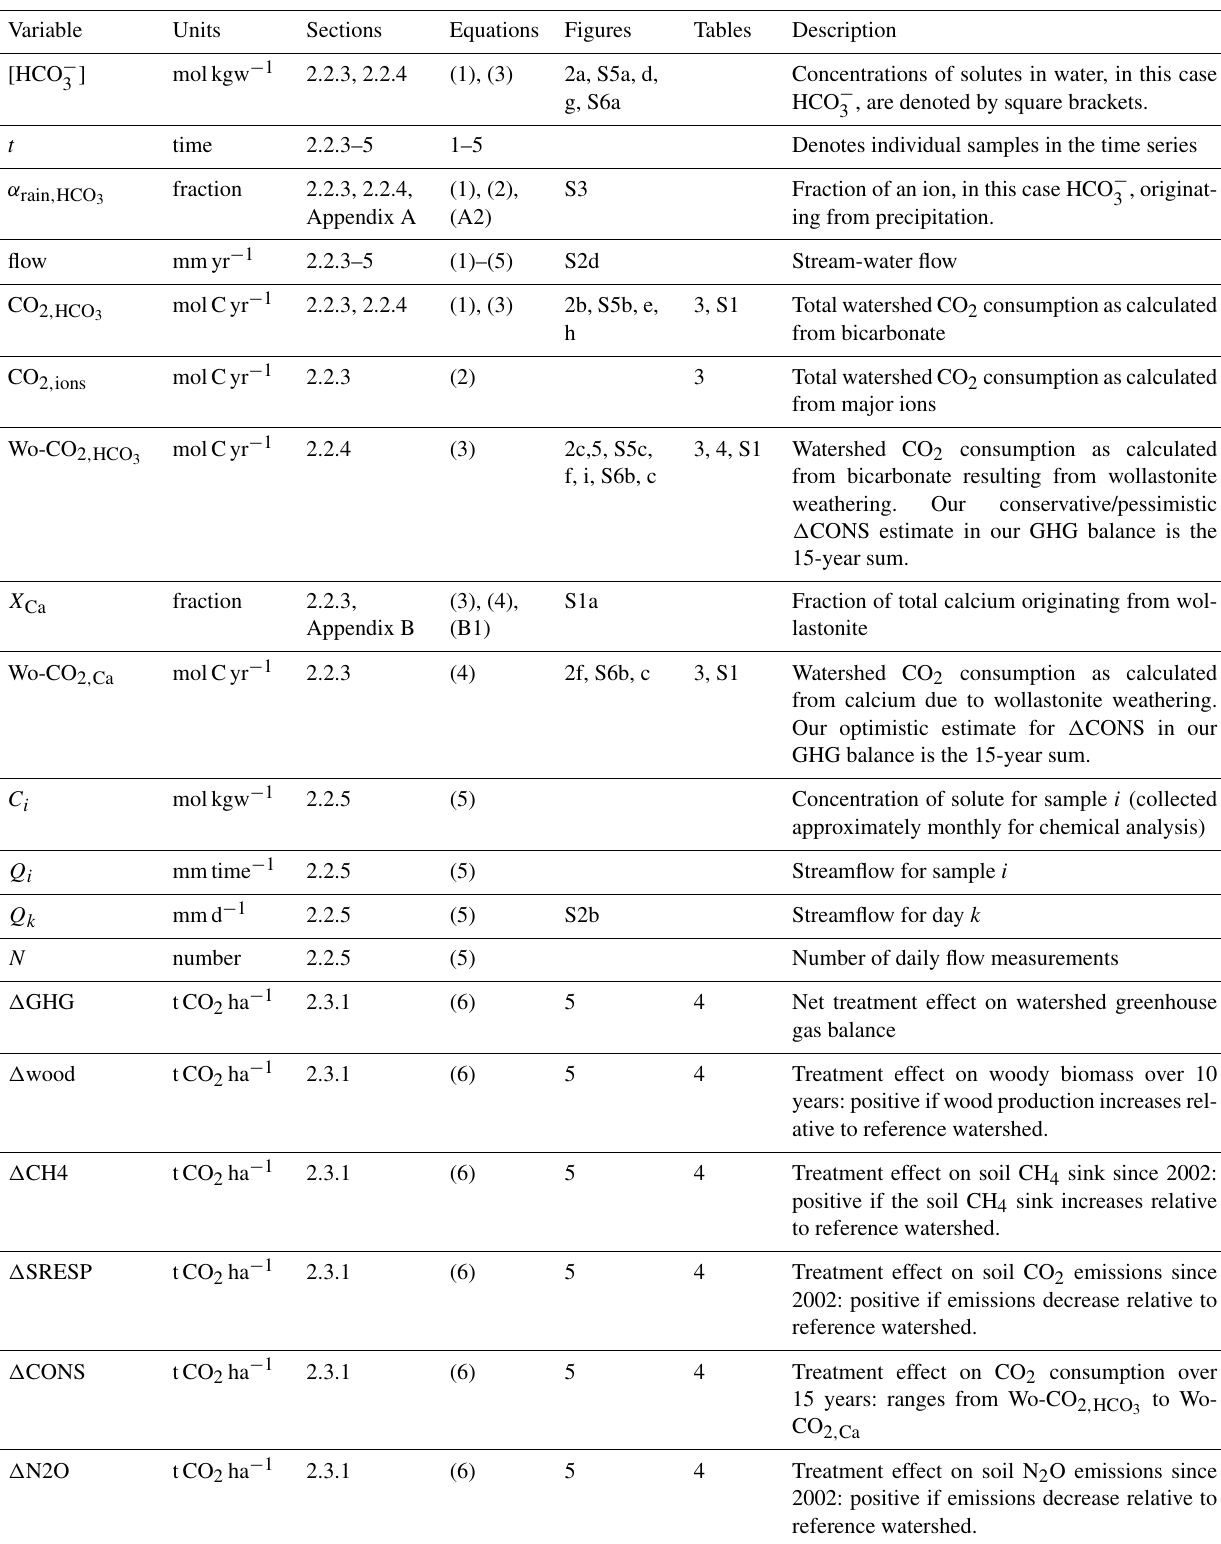
Table 1. Summary of variables presented in Methods (Sect. 2, Eqs. 1 through 7).